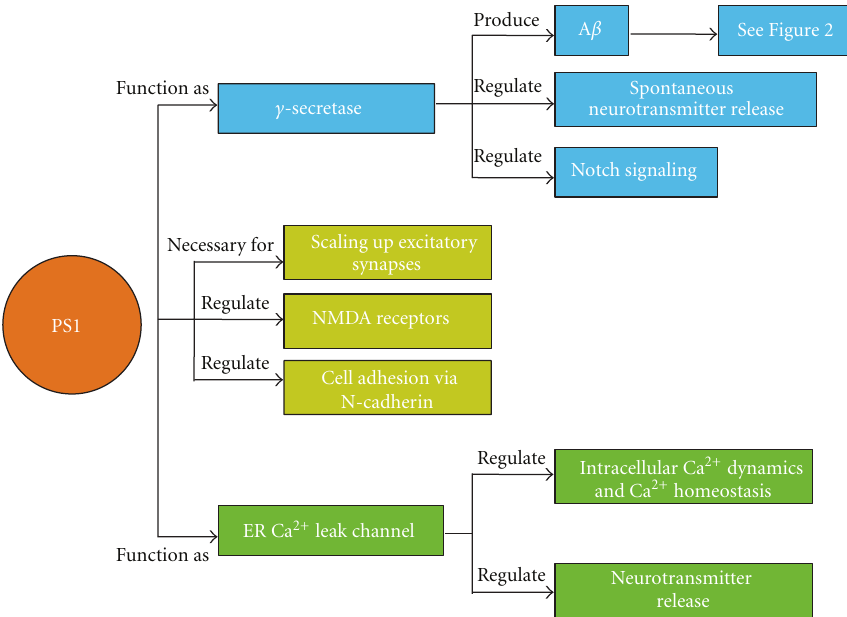
Figure 4: The roles of presenilins in synaptic function. Two main functions of presenilin 1 (PS1) focused on in this paper are its ability to function as part of the γ -secretase cleavage complex and also to function as an ER Ca 2+ leak channel. The γ -secretase complex is responsible for the final cleavage of APP in the production of A β peptides. The γ -secretase complex has also been shown to regulate spontaneous neurotransmitter release and is crucial for the regulation of the notch signaling pathway especially during early development. The PS1 holoprotein has been proposed to function as an ER Ca 2+ leak channel. It is responsible for regulating intracellular calcium dynamics and calcium homeostasis required for proper signaling and neurotransmitter release. In addition to these two main functions, knockout studies have shown that the PS1 protein is important for synaptic scaling, proper NMDAR-mediated responses, as well as cell adhesion mediated by N-cadherin. Through these studies it is clear that PS1 plays an important role in synaptic transmission and